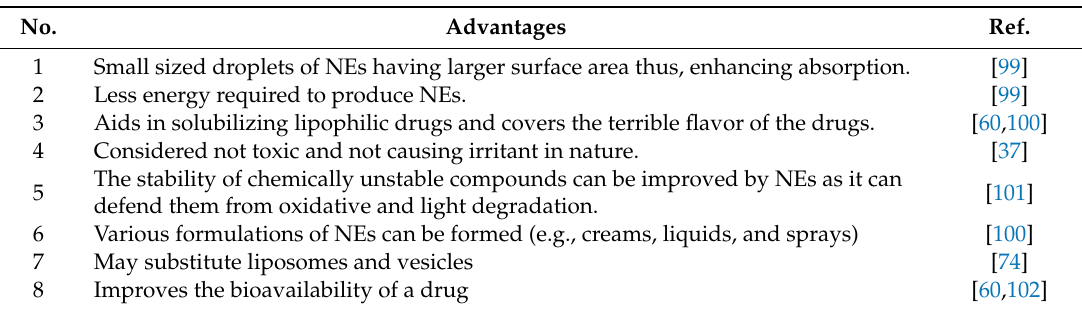
Table 4. Advantages of NEs.